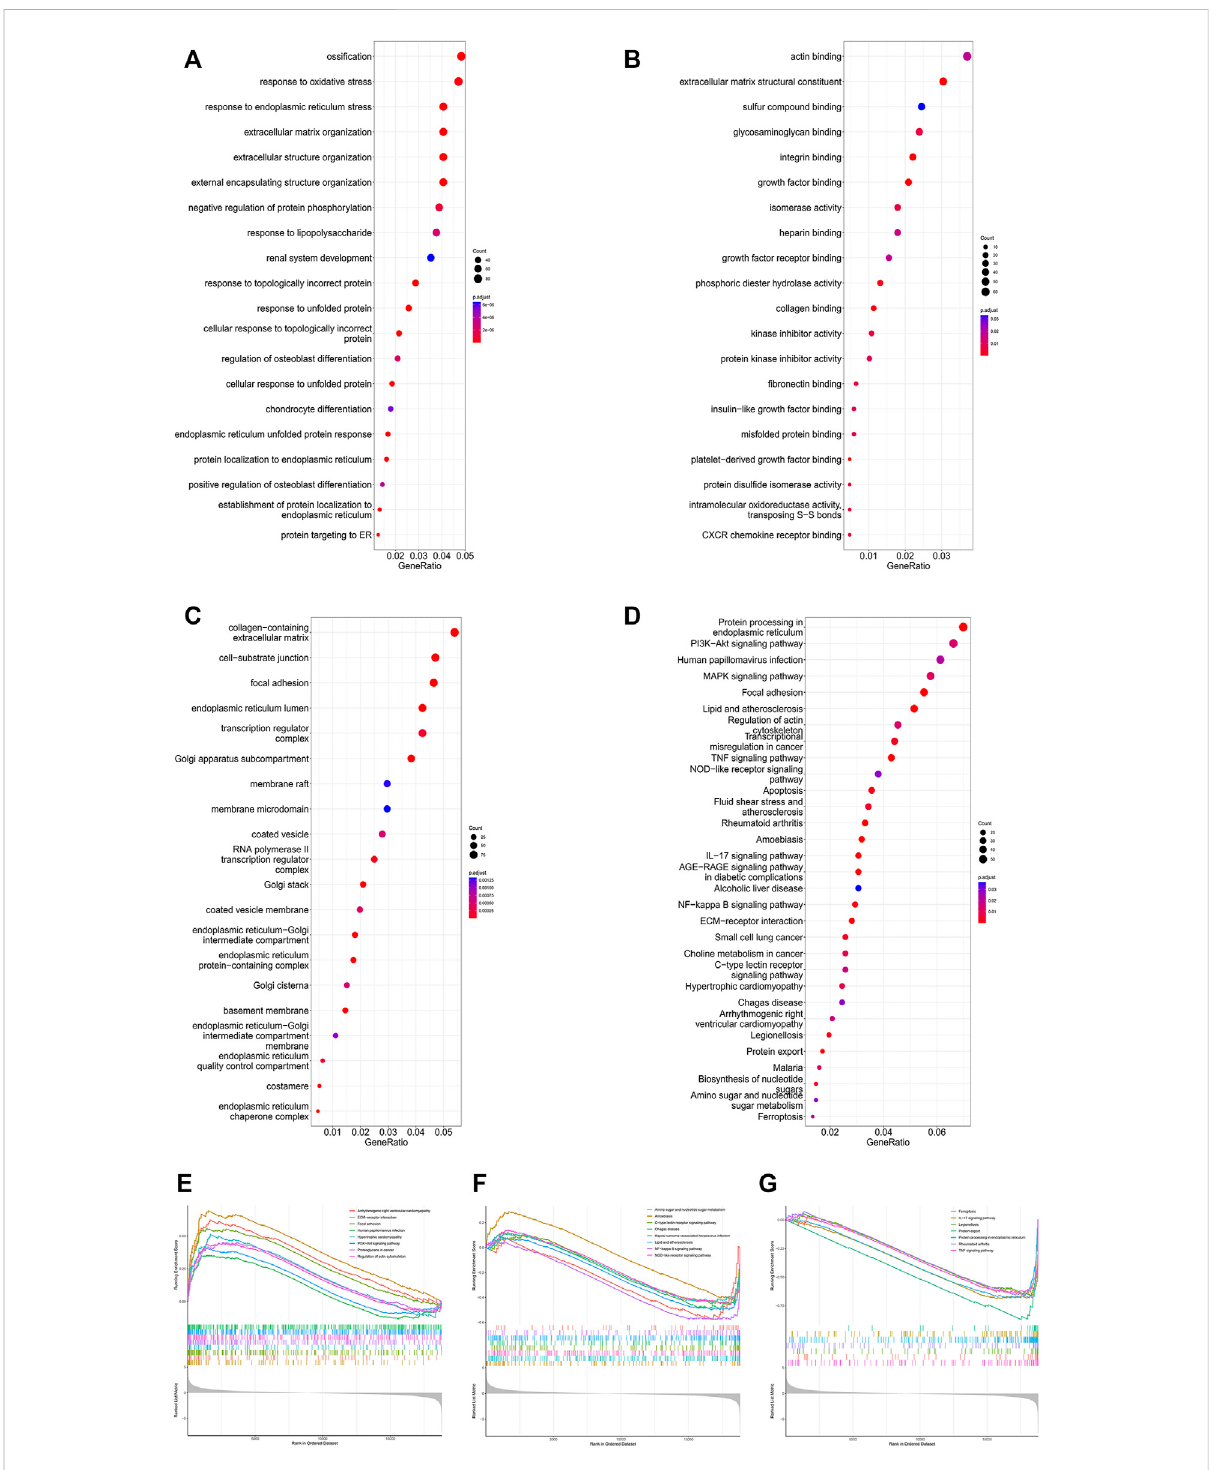
FIGURE 2 Enrichment analysis of DEGs in the GSE100900 dataset The top 30 BPs (A) , MFs (B) and CCs (C) in the GO analysis of microgravity-sensitive genes in osteogenic medium (FOMvsGOM) are shown (D) KEGG analysis of microgravity-sensitive genes in osteogenic medium (FOMvsGOM). The size of the circle indicates the gene count. The color of the circles represents the adjusted p value (E – G) The 23 terms of GSEA that overlapped with the KEGG results are